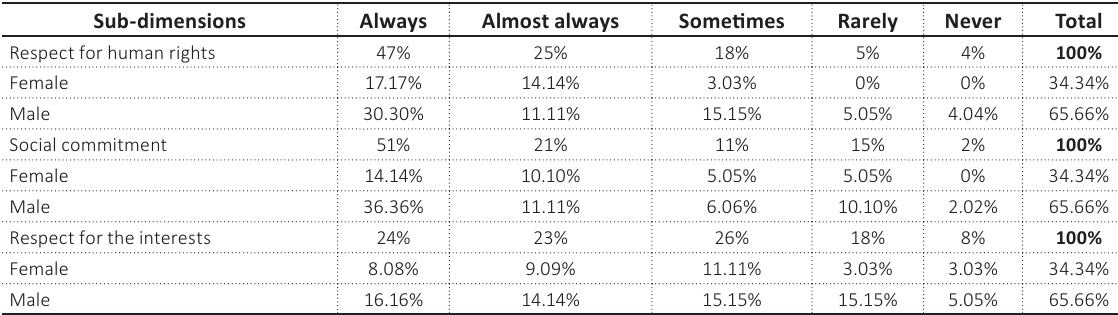
Table 3. Social responsibility and